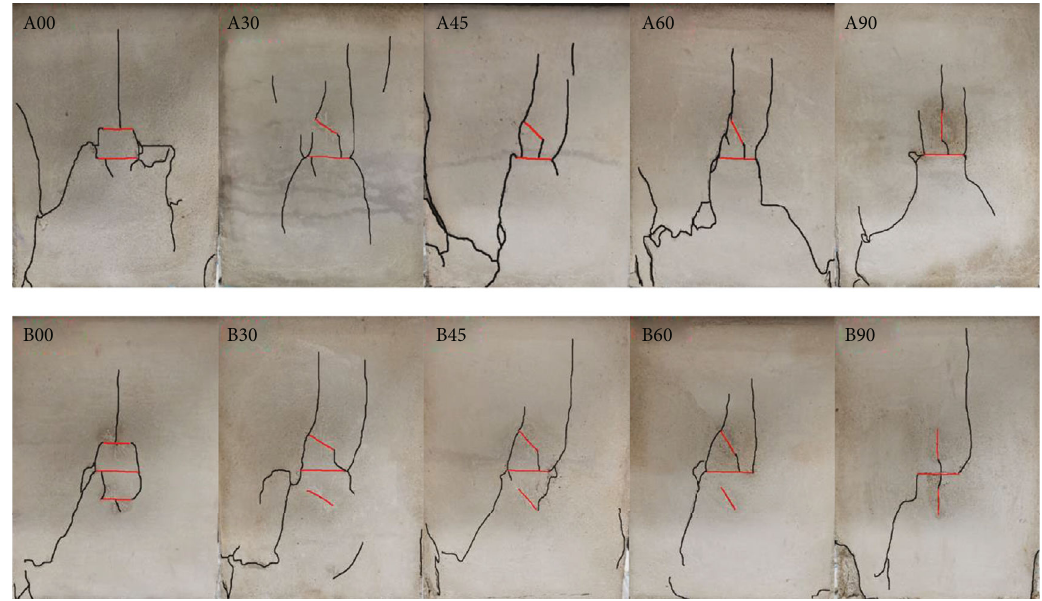
Figure 8: Crack propagation in the